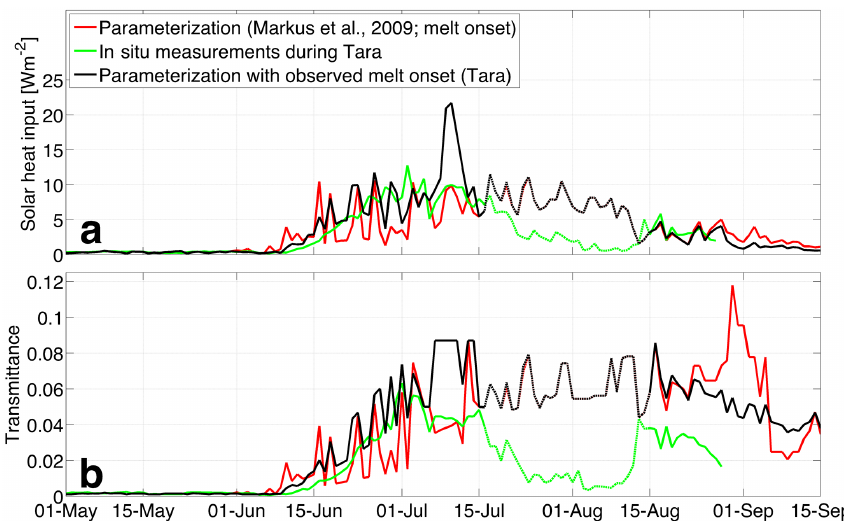
Figure 6. (a) Transmitted total solar heat input and (b) total transmittance during the drift of Tara in 2007 (Nicolaus et al., 2010b). Compared are in situ measurements (green) with the presented method (red) and the presented method, but using the observed dates for phase transitions. Between 16 July and 14 August (dotted lines), a comparison is not reasonable, since the sensor was strongly influenced by biological processes during